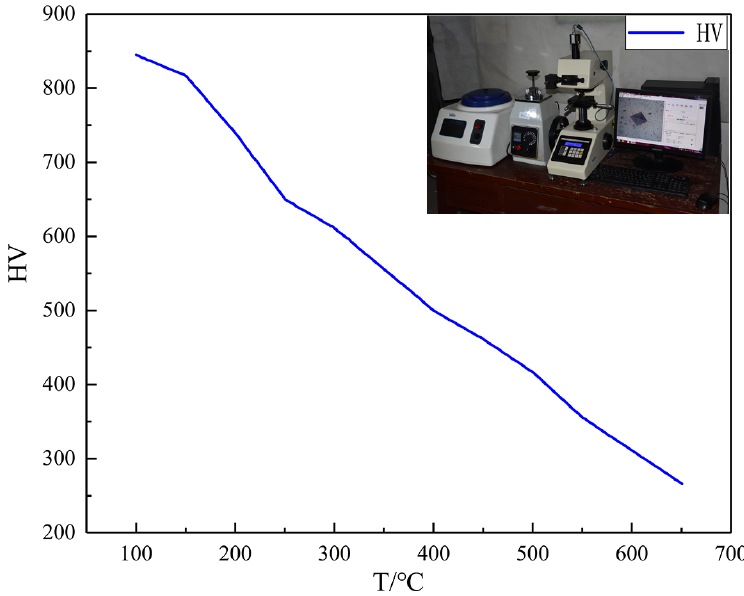
Figure 5. HT-V Figure 5. HT-V Curve.